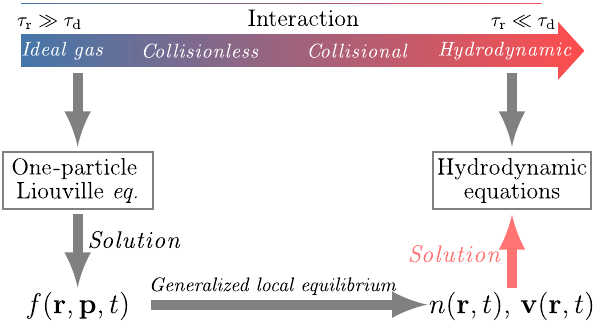
FIG. 1. Ideal-gas approach hydrodynamics. The one-particle Liouville equation for ideal gases and the hydrodynamic equa- tions for interacting systems, respectively, work for two opposite limits. Here, we show, unexpectedly, that the solution to certain one-particle Liouville equation of ideal gases can be used to construct the solution to a set of hydrodynamic equations if a generalized local-equilibrium condition [Eq. (8)] can be satisfied.